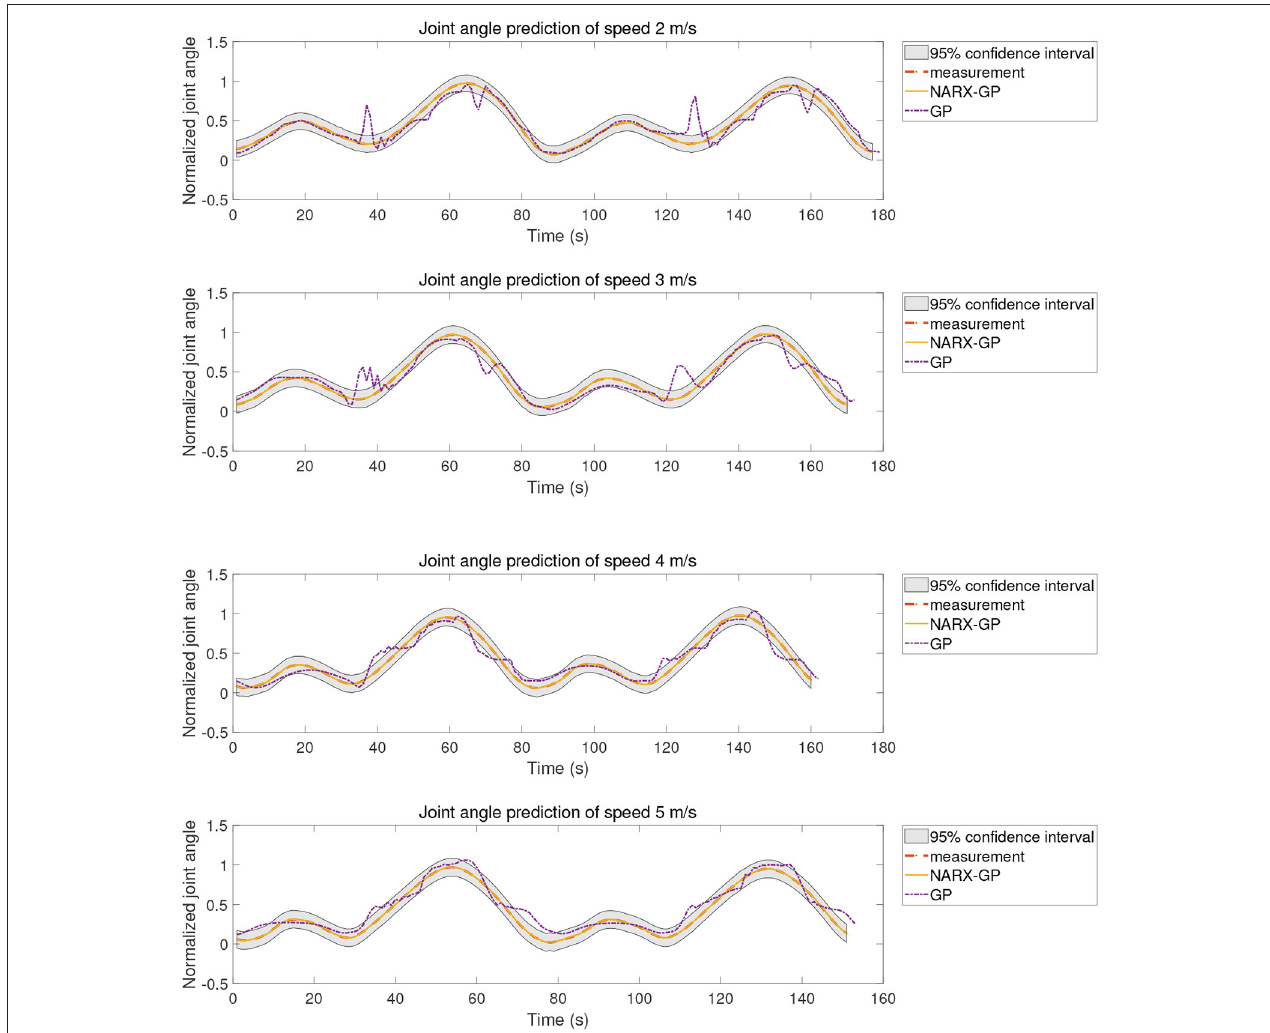
FIGURE 6 | Joint angle prediction under speed-dependent of subject